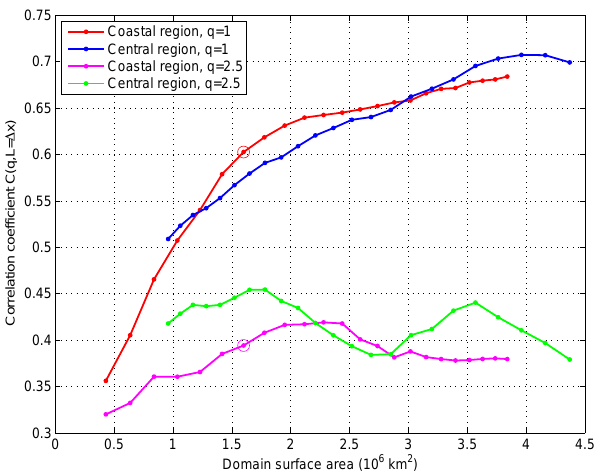
Fig. 6. Variability of C(q,L = 1x) with changing size of the two analyzed sub-domains, the “coastal” region and the “central” region (Fig. 5), for q = 1 and q = 2 . 5. Data points corresponding to the width of the coastal region equal to 400 km are marked with circles.